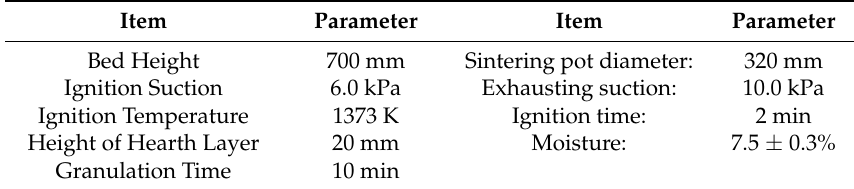
Table 5. Parameters of the sintering test.